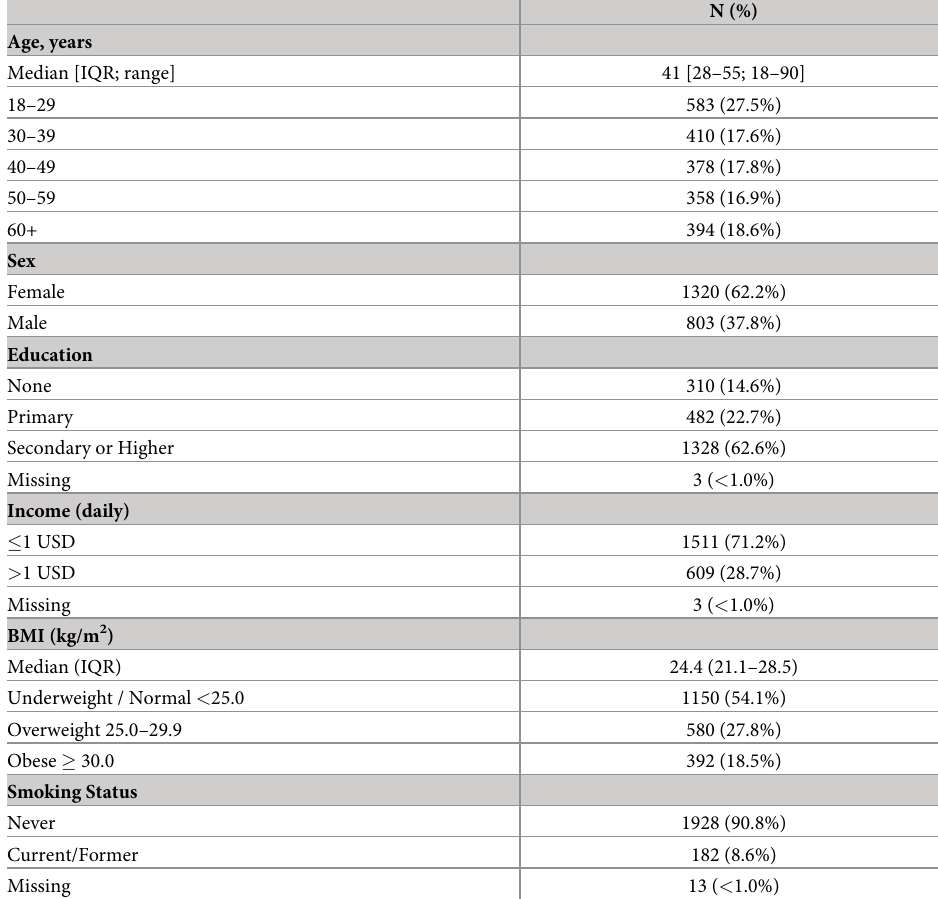
Table 1. Characteristics of participants in the Haiti CVD cohort study (N =